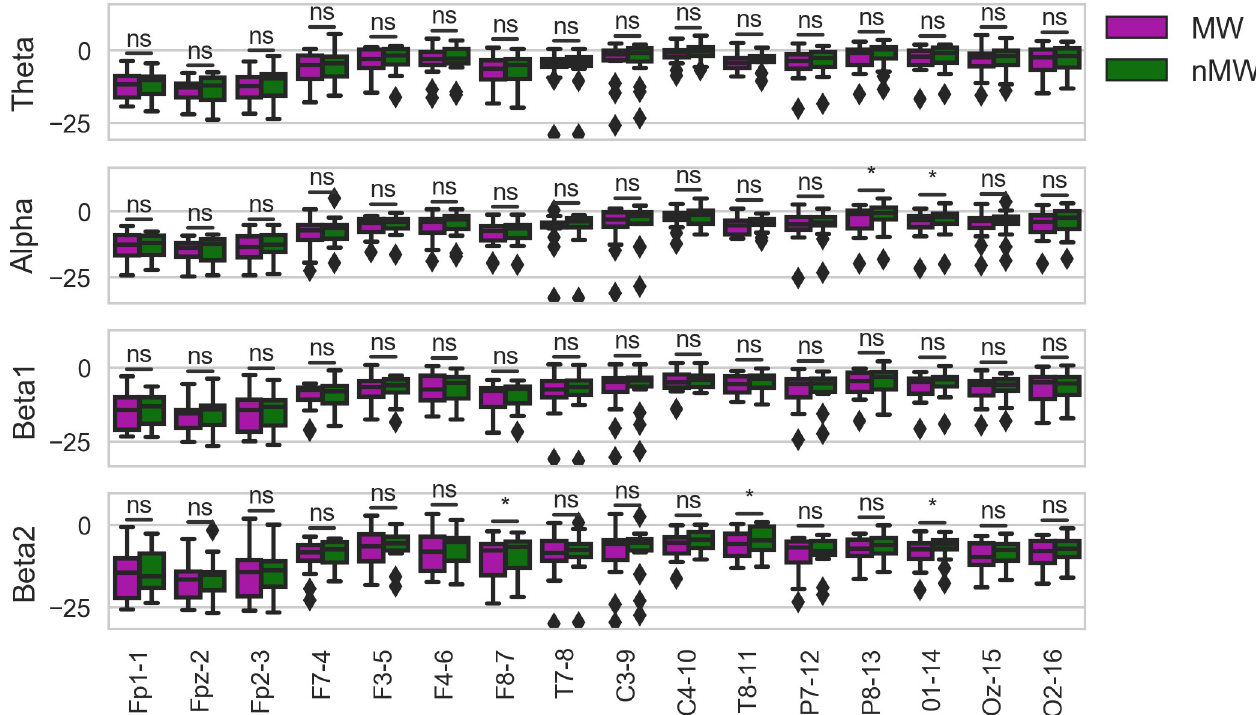
Fig 3. Power spectrum distributions for each channel in each frequency band, aggregated across participants. Statistical significance is calculated using paired-samples t-tests. Uncorrected p -values are reported as follows: � , p < 0.05, �� , p < 0.01, ��� , p < 0.001, ���� , p < 0.0001.